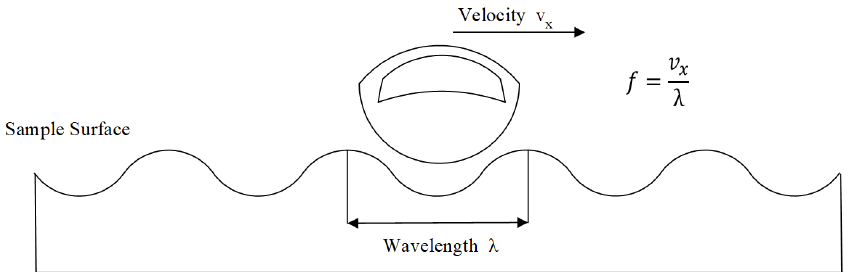
Figure 11. Definition of surface from using wavelength λ